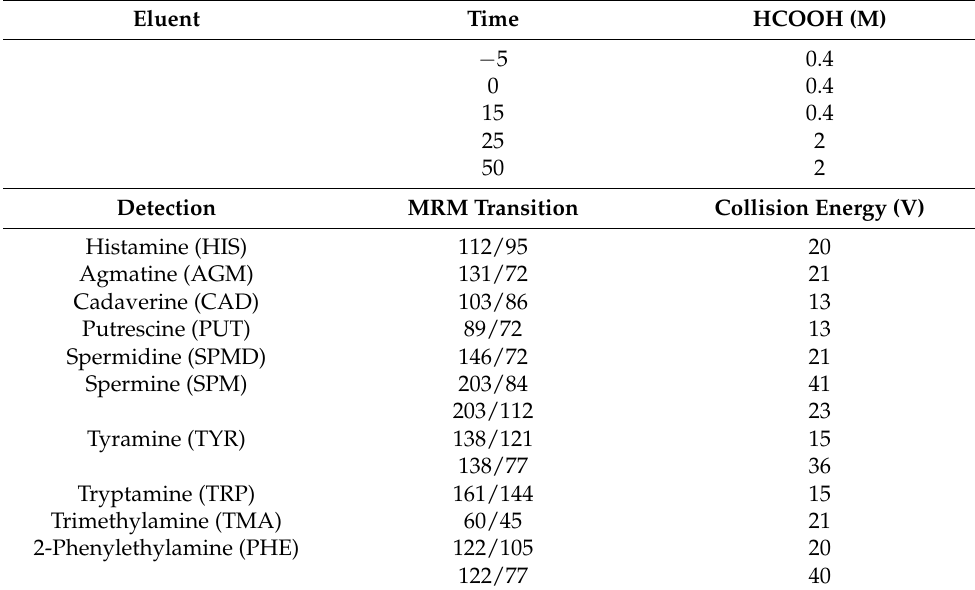
Table 1. Experimental conditions of the IC-MS/MS